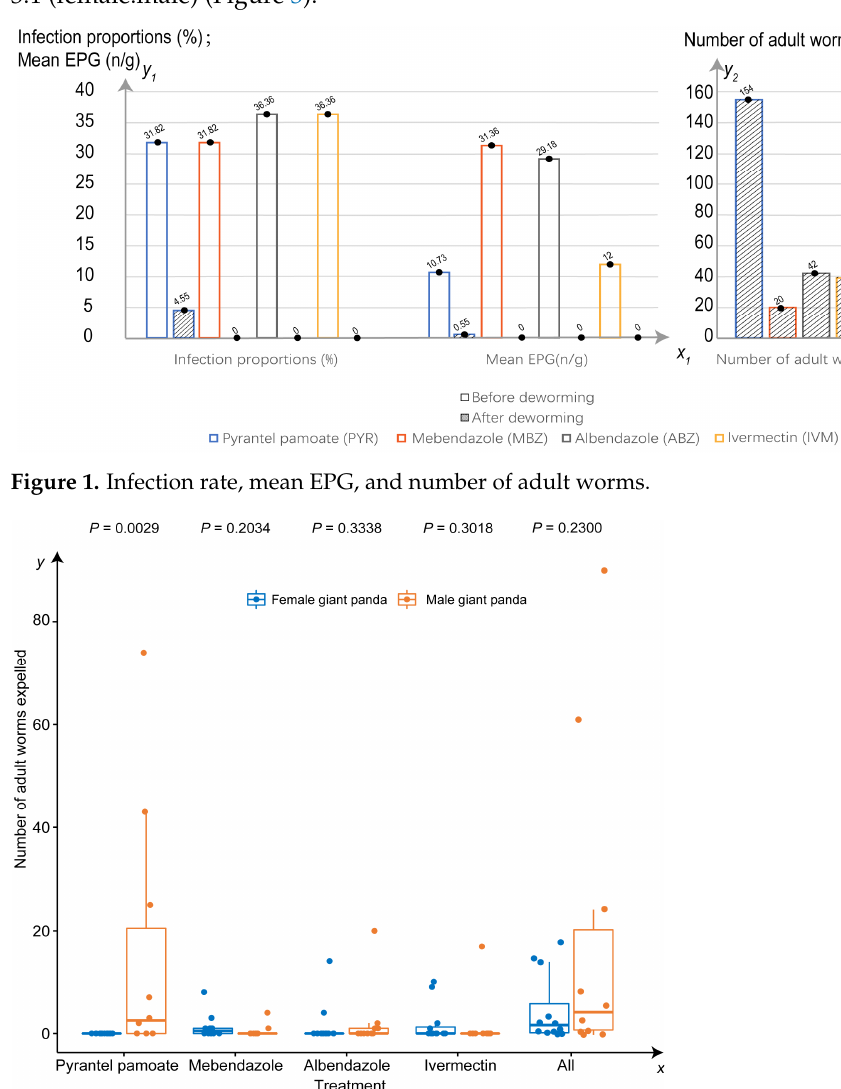
Figure 3. Sex ratio of expelled worms. 4. Discussion This is the first report on the possibility of PYR resistance in B. schroederi and provides preliminary insight into the current state of AR in captive giant pandas in China. There are some reports of PYR resistance in Parascaris spp. [20,25–27]. By the interpretation